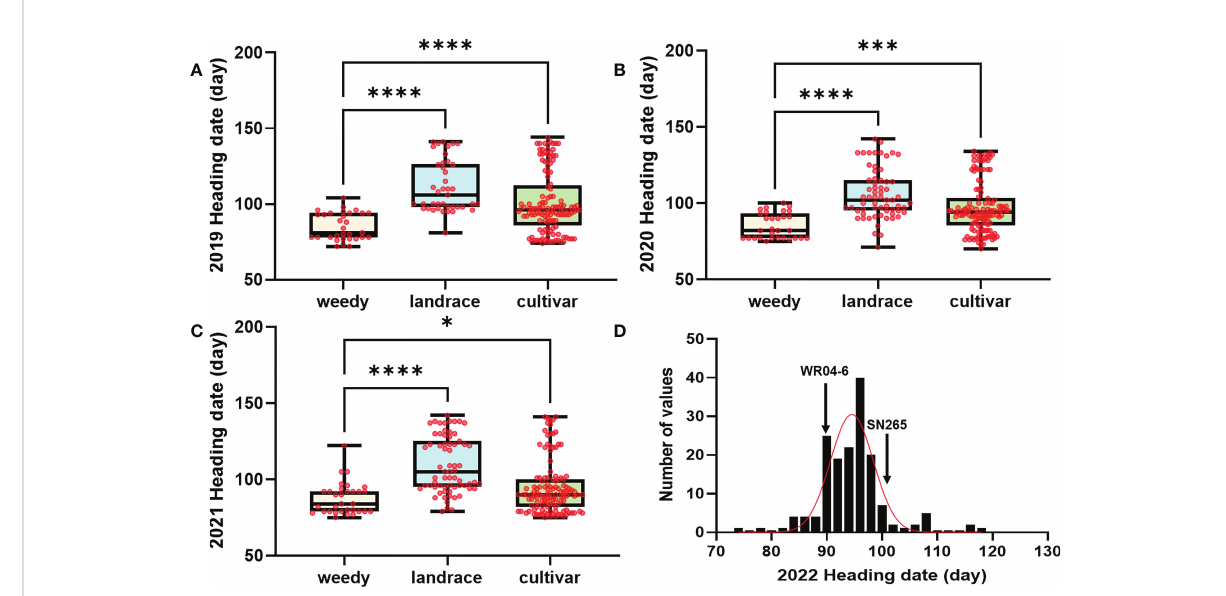
FIGURE 1 The heading date in the GWAS and RIL population. (A – C) The heading date of weedy rice, landrace, and japonica cultivar for 2019, 2020, and 2021 in the GWAS population. (D) Distribution of the RIL progenies of the weedy rice WR04-6 and japonica cultivar SN265. Bars are the maximum and minimum values of samples. Data were analyzed by one-way ANOVA multiple comparisons. ****, ***, and * represent signi fi cant differences at P = 0.0001, P = 0.001, and P = 0.05, respectively; red dots indicate samples. The D ’ Agostino – Pearson test method was used for the normal distribution test. weedy, weedy rice; landrace, japonica landrace; cultivar, modern japonica